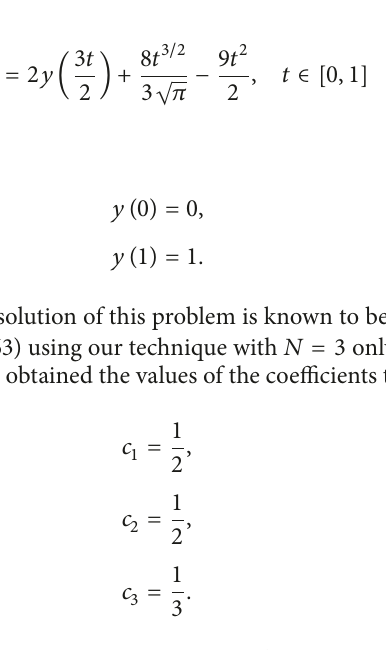
Table 3: Comparison of the absolute errors obtained by the present method and those obtained in [1] for Example 2. 𝑡